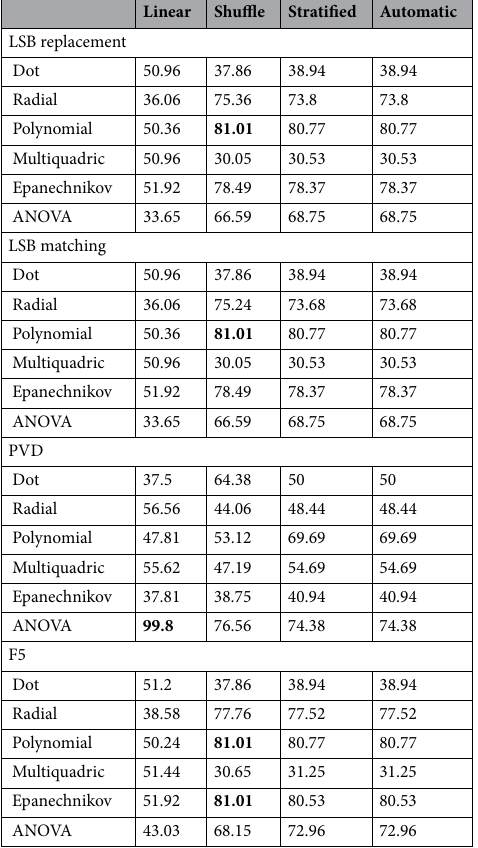
Table 5. Classification of uncalibrated images using SVM-PSO for random %. Significant values are in bold.